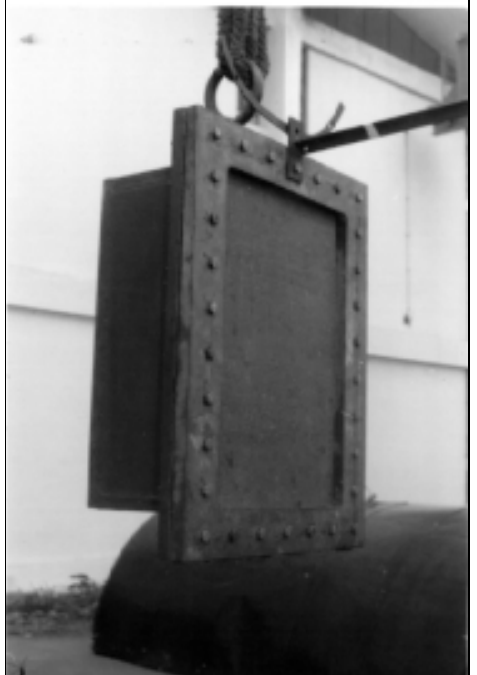
Fig. 1. Panel test